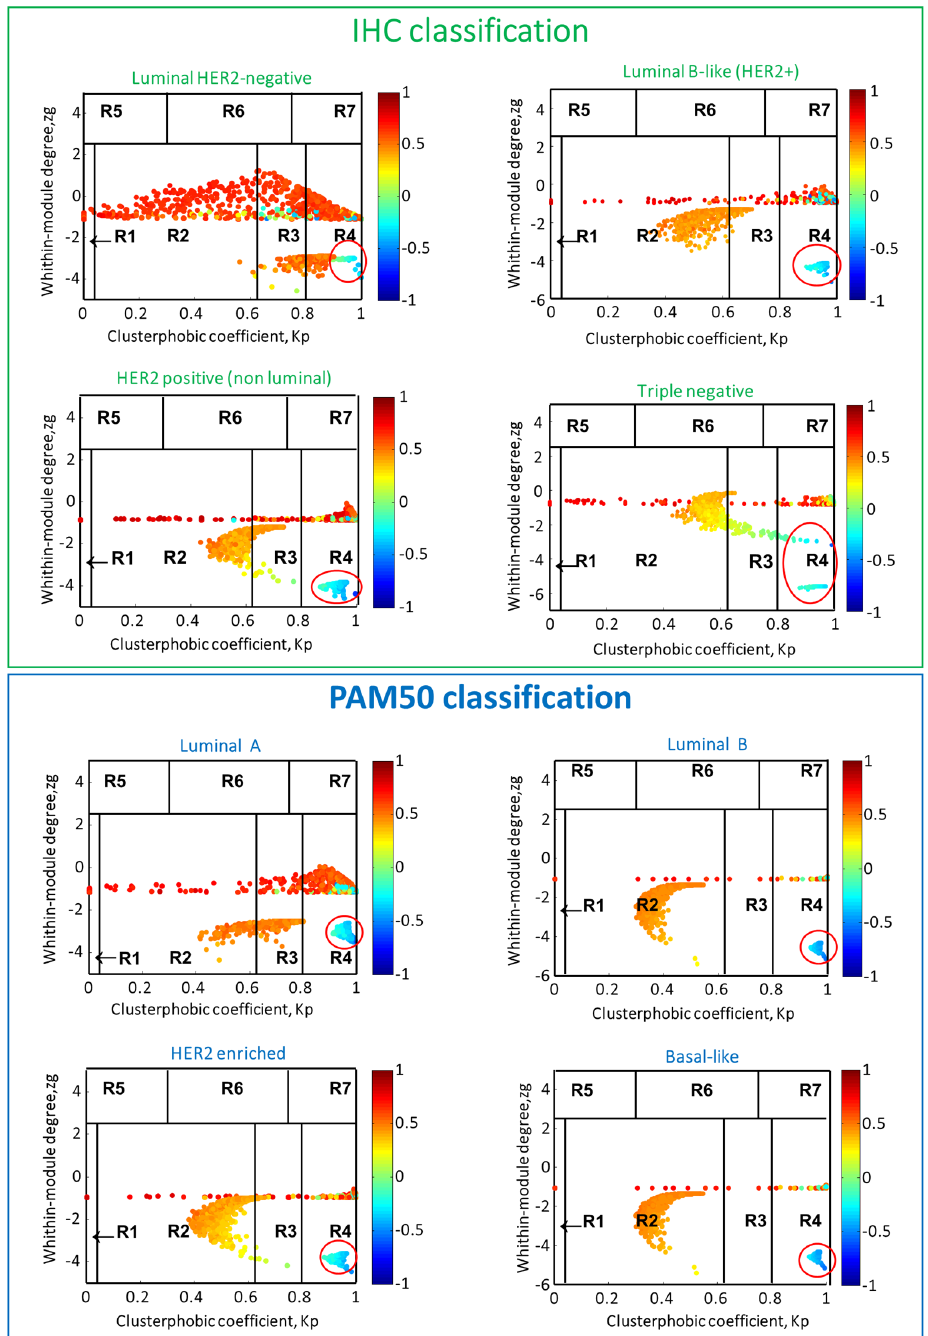
Figure 2. Heat cartography maps for each breast subtype. The cartographic representation of the correlation network of each analyzed breast subtype is reported. The x and y axes correspond to the within-module degree zg and the clusterphobic coefficient Kp, respectively. The within-module degree zg measures how “well-connected” each node is to other nodes in its own cluster, and the clusterphobic coefficient Kp measures the “fear” of being confined in a cluster. High zg values correspond to nodes that are hubs within their community, while high values of Kp identify nodes that interact mainly outside their community, i.e., with many more external than internal links [8]. Dots correspond to nodes in the networks colored according to the value of the Average Pearson Correlation Coefficients (APCC) between its expression profile and that of its nearest neighbors. Switch genes correspond to nodes colored in blue and falling in R4 region (highlighted with a red circle).